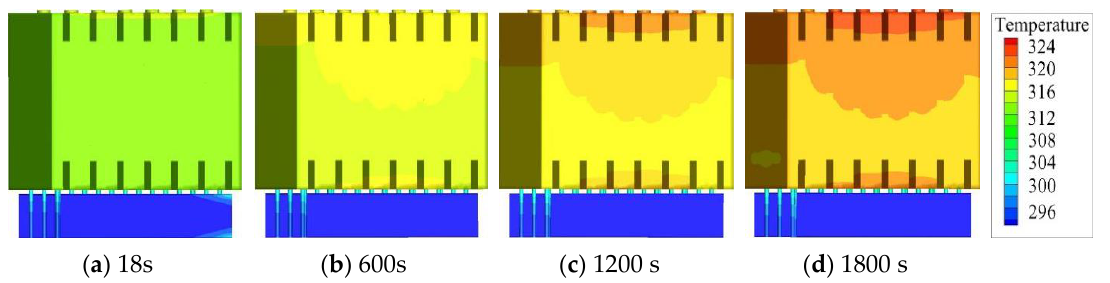
Figure 11. Temperature cloud graphs of battery pack at ambient temperature of 313 K.